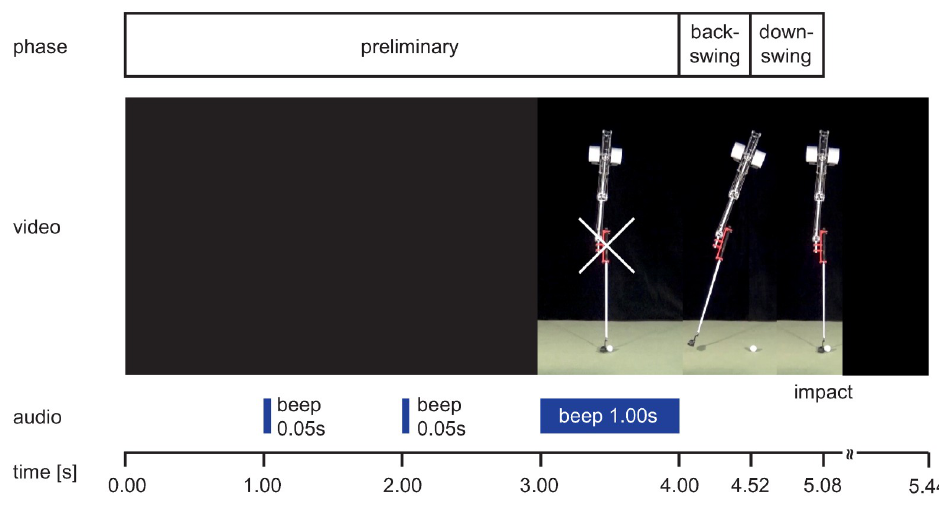
Fig 5. Video sequence in the incomplete vision condition. Sequential presentation of a 2.0 m putt video in incomplete vision condition with information about swing phase, audio signals and timing (video sequence see S2